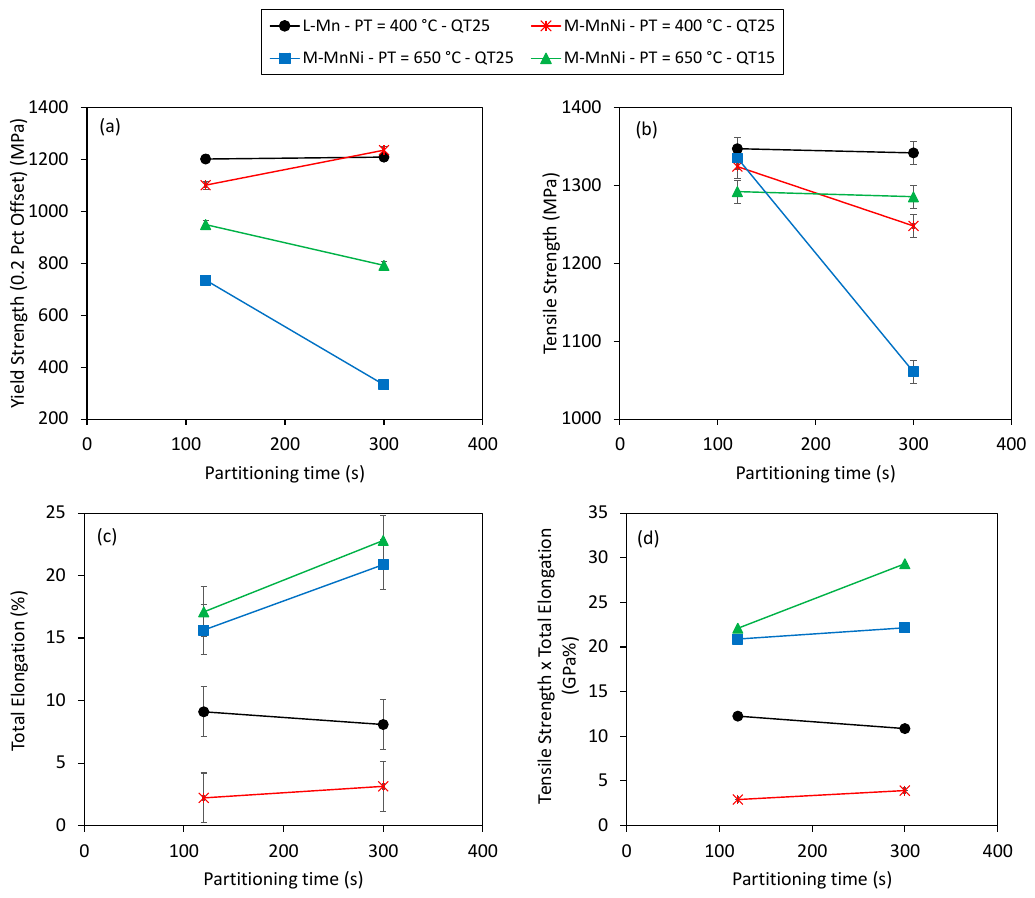
Figure 13. Tensile properties as a function of partitioning time after Q&P treatments of L-Mn and M-MnNi steels with different PTs (400 °C and 650 °C) and QTs (QT15 and QT25): ( a ) Yield strength; ( b ) Tensile strength; ( c ) Total elongation; ( d ) Product of tensile strength and total elongation. Bending and hole expansion results are also represented as a function of partitioning